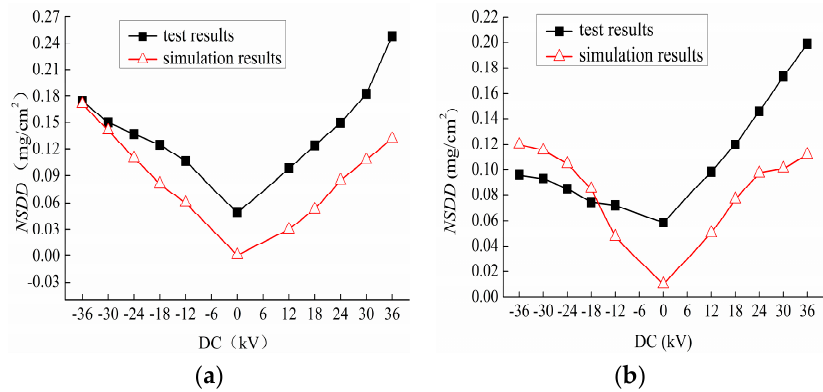
Figure 4. Comparison of the test results and simulation results, ( a ) porcelain three-umbrella insulator XSP-160; and ( b ) porcelain bell jar insulator XP13-160.